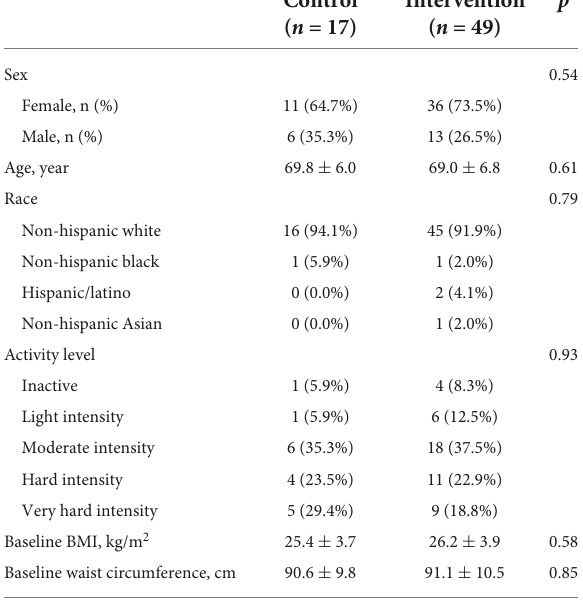
TABLE 1 Participant demographics*.